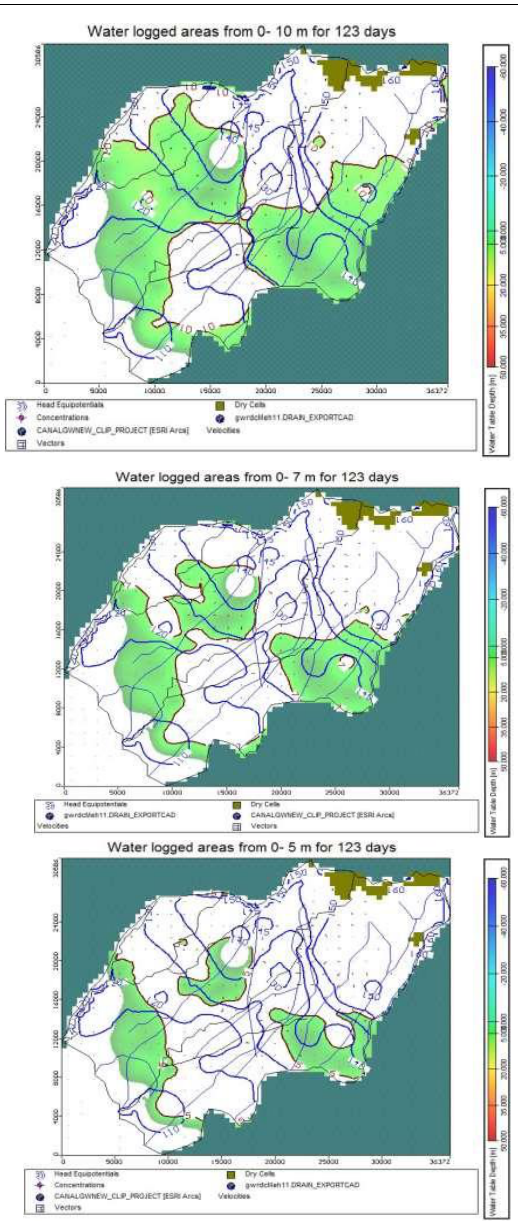
Figure 15 Water logging Area in different Time